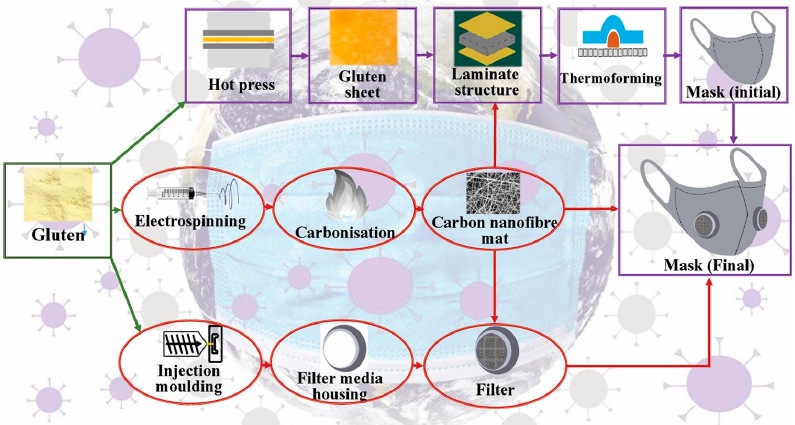
Figure 8. Proposed pathway to produce gluten-based and biodegradable face masks [52], reproduced with permission. Copyright Elsevier Ltd.